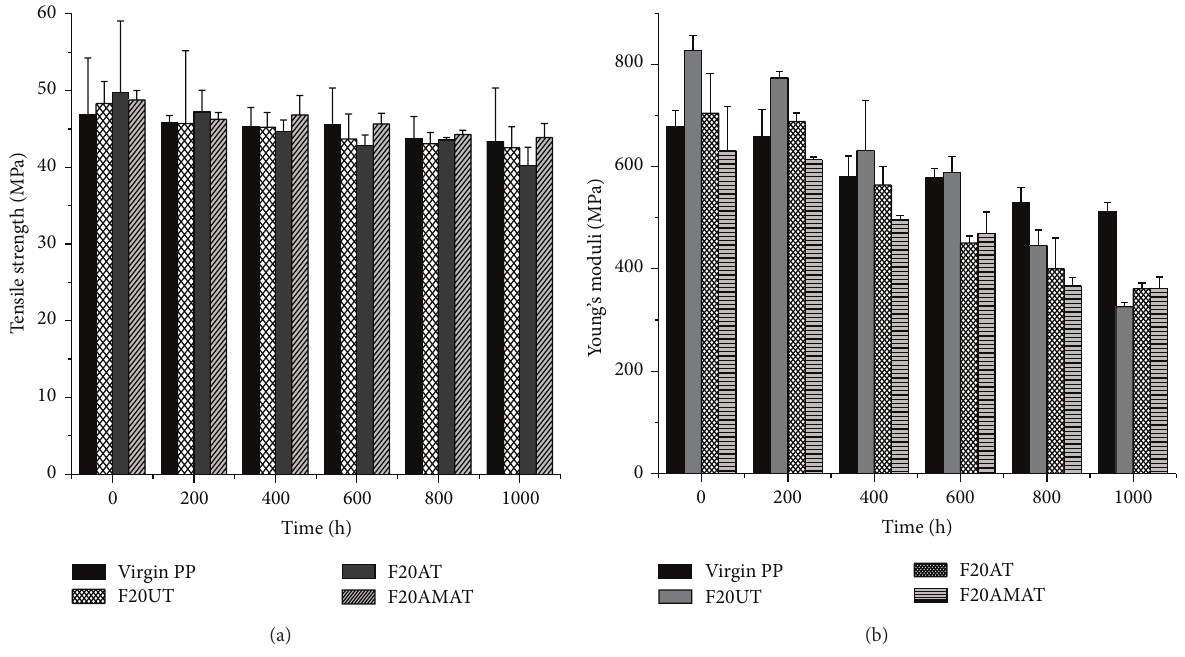
Figure 3: Evolution of the mechanical properties of the PP/alfa fiber composites: (a) tensile strength and (b) Young’s moduli.